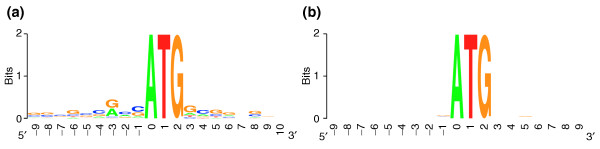
ATG codon context in the riken1 cDNA sequences. (a) Sequence logo of annotated start codon context. (b) Sequence logo of the context of ATGs found upstream of the annotated start codons. Figure created using WebLogo [35].